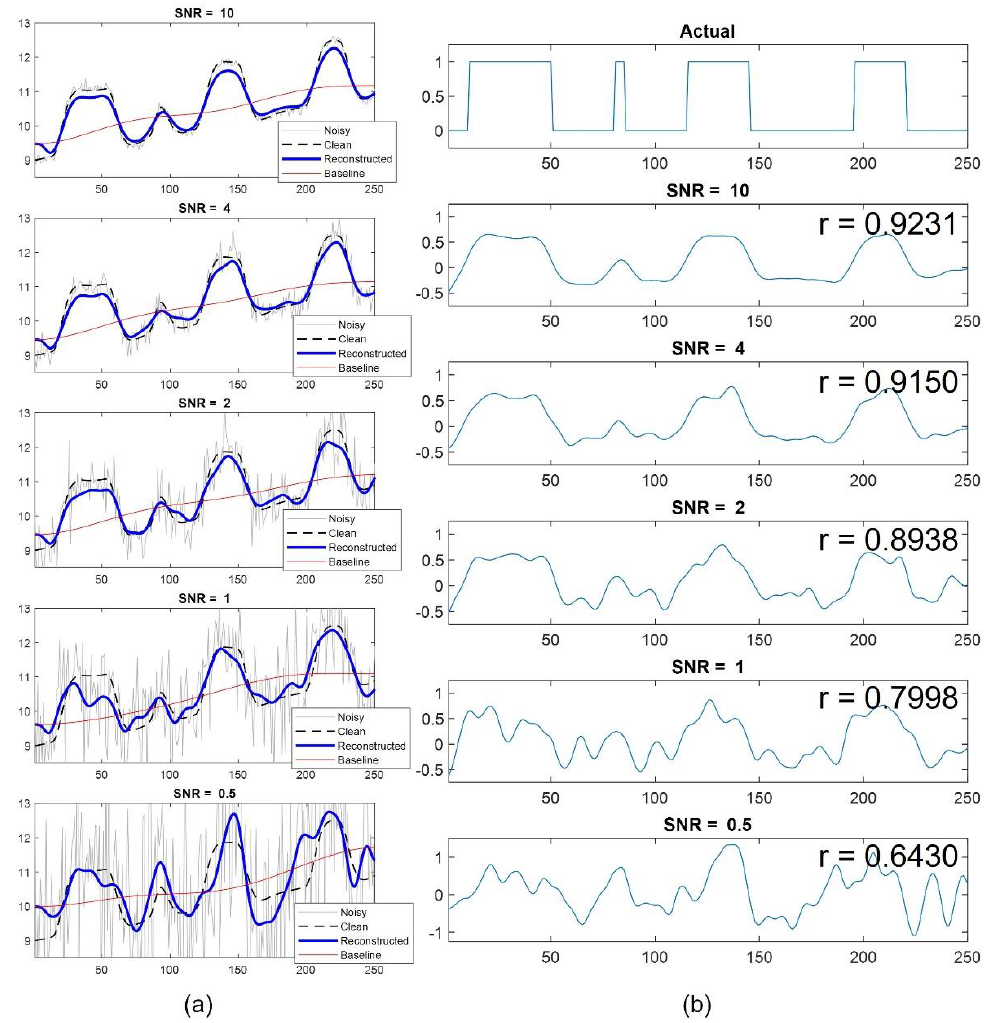
Figure A1. Comparison of the ( a ) time series reconstruction and ( b ) the estimated pseudo-stimulus for different noise levels. Varying noise levels are indicated using signal-to-noise ratio (SNR).